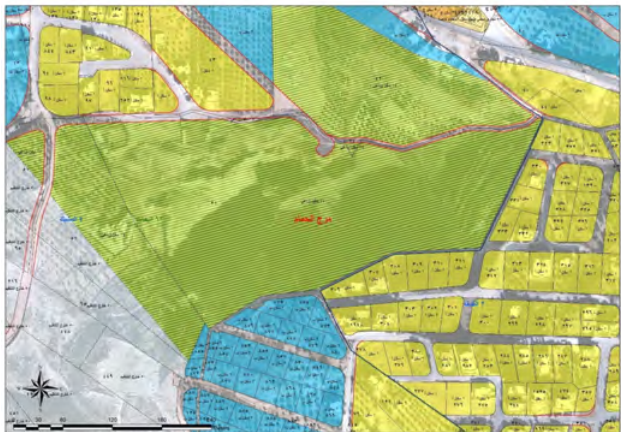
Figure 12. Discontinued quarry site land use over aerial view map. Source: GAM- GIS for the author